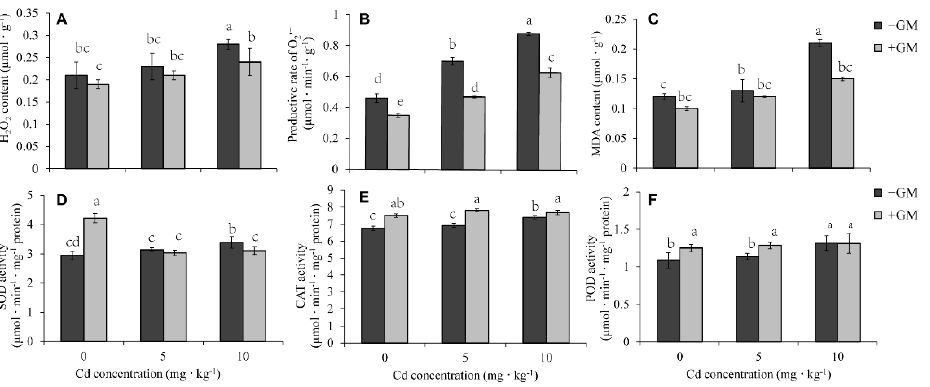
Figure 3. Effects of AMF on H 2 O 2 , O 2 •− , MDA content ( A – C ) and SOD, CAT, POD activity ( D – F ) under Cd treatment. Values are the means ± standard deviation (SD) ( n = 3). Different letters in the same column indicate statistically significant differences ( p < 0.05).